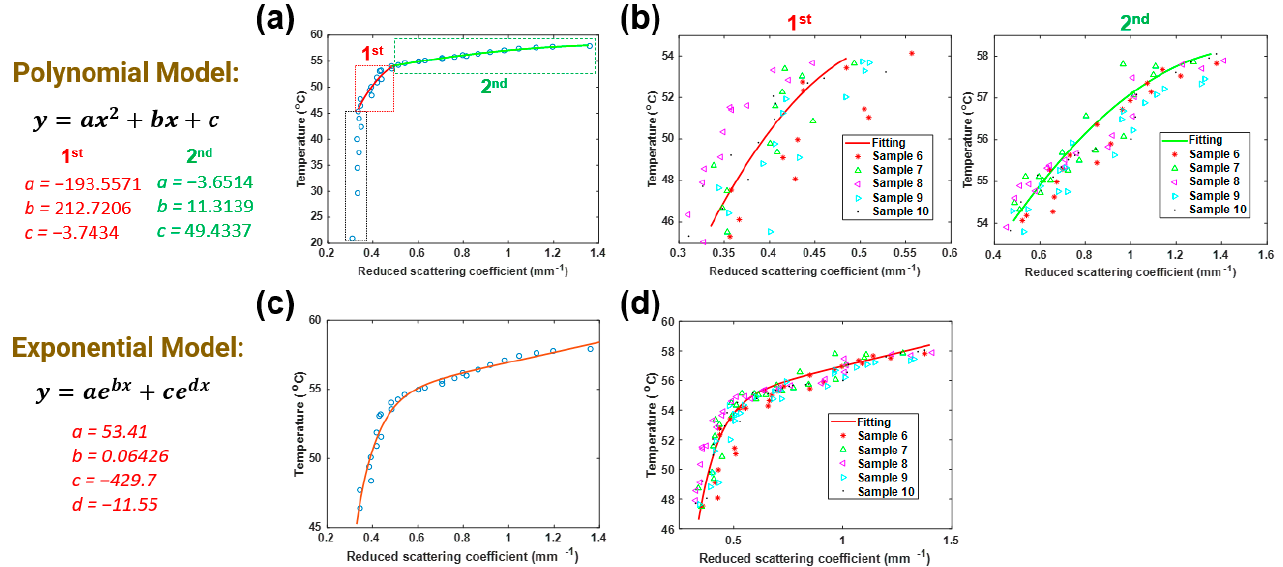
Figure 3. Fitting ( a ) polynomial model and ( c ) exponential model to measured DOT data of porcine muscle tissues. Comparison between the temperatures calculated/predicted by ( b ) polynomial and ( d ) exponential methods (solid line), and those measured by a thermometer (scattered points) as a function of µ (cid:48) s . Table 1. Root mean square error (RMSE) of five porcine muscle tissues (units: °C). S1 S1 S2